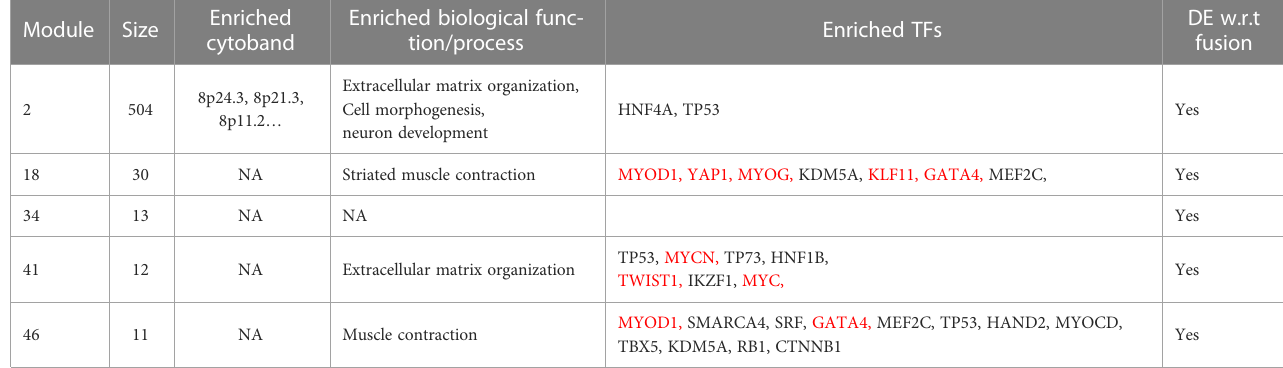
Sig.DE, signi fi cantly differentially expressed. Red font indicates signi fi cantly differentially expressed. NA indicates not signi fi cantly